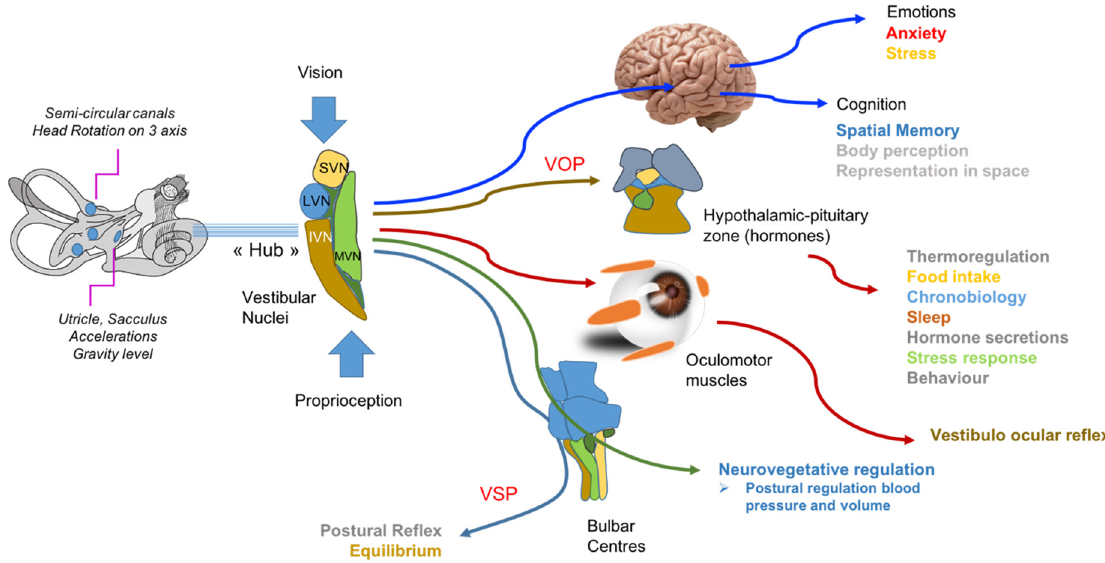
Figure 1. Biomarkers at the different levels of vestibular sensory information integration. VSP: Vestibulo Spinal Pathway; VOP: Vestibulo Ocular Pathway. SVN: Superior Vestibular Nuclei; MVN: Medial Vestibular Nuclei; LVN: Lateral Vestibular Nuclei; IVN: Inferior Vestibular Nuclei: Courtesy Dr S Besnard.